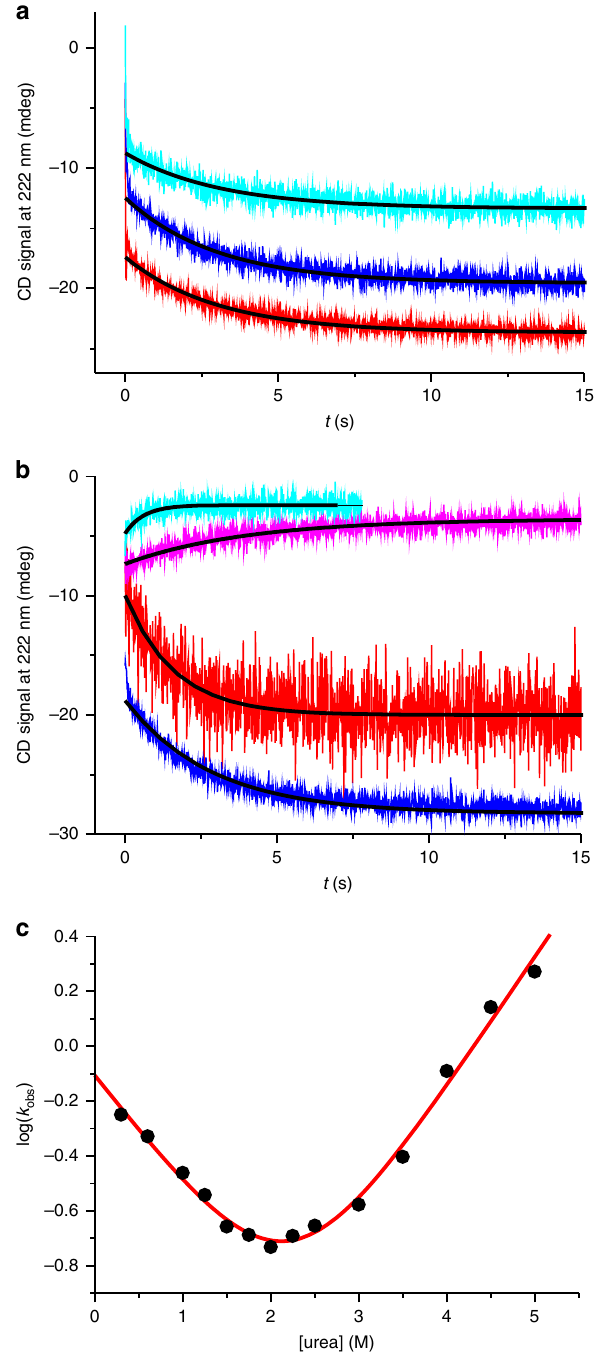
Fig. 3 Folding kinetics of N-terminal helices. a Kinetic transients of refolding measured using far-UV CD stopped- fl ow spectroscopy. Chemically reduced and denatured wild-type CTD samples at 24 (cyan), 38 (blue), and 100 µ M (red) protein concentration, refolded by rapid mixing into pH 7.0 buffered solution. Transients are offset along the y -axis for reasons of clarity. Black lines are fi ts to the data using a mono-exponential decay function. b Representative kinetic transients of folding (red: in 0.3M urea; blue: in 1.0M urea) and unfolding (magenta: in 2.5M urea; cyan: in 4.5M urea) of nonreduced wild- type CTD measured using far-UV CD stopped- fl ow spectroscopy. Transients are offset along the y -axis for reasons of clarity. Black lines are fi ts to the data using a mono-exponential decay function. c Observed rate constants plotted versus denaturant concentration (chevron plot). The red line is a fi t to the data using the kinetic model for a barrier-limited two-state